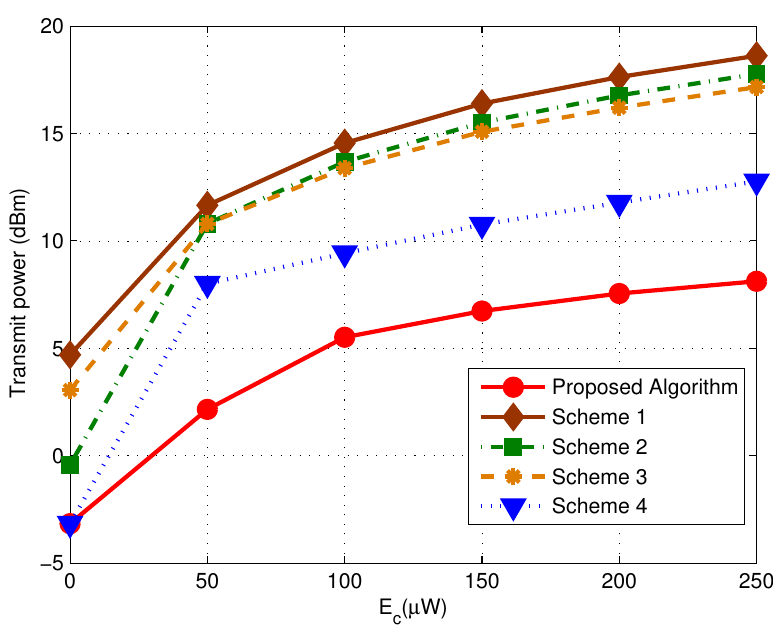
Figure 5. Transmit Power versus the harvest energy E c for the proposed algorithm ( σ 2 = − 112 dBm and K = 12, the RNs are evenly divided into 3 groups, with the corresponding BER target of each group = 10 − 2 , 10 − 4 and 10 − 6 ).